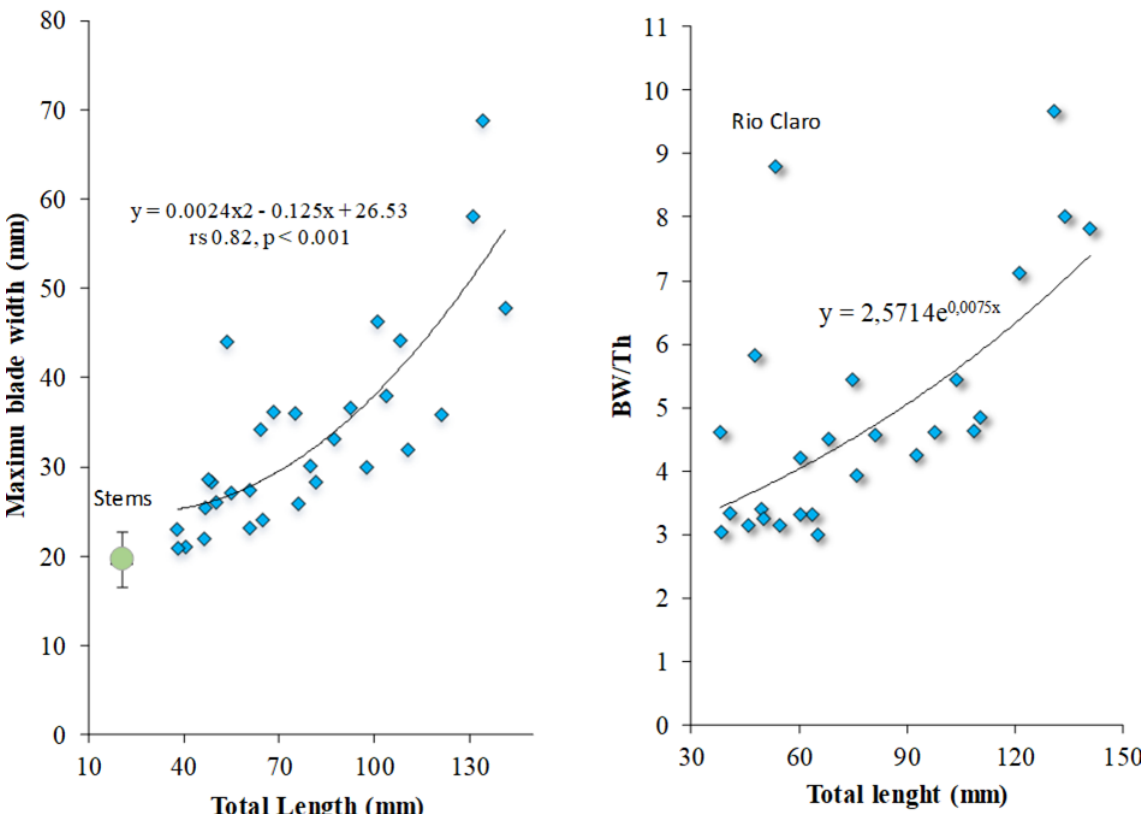
Figure 18. Left: biplot of the maximum length of the FPs and the maximum width of the blade. The green spot represents the stem sizes (± 1 σ). Right: biplot of the maximum length and the ratio blade and thickness.